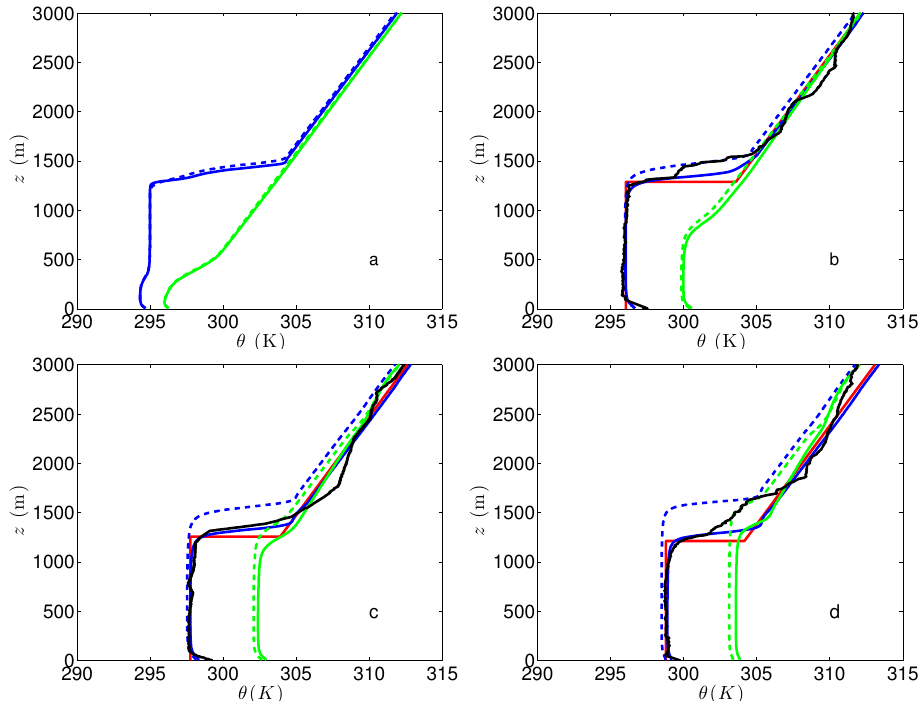
Fig. 3. Vertical profile of the 30-minutes averaged potential temperature at (a) 08:30, (b) 11:00, (c) 14:00 and (d) 17:00 UTC on 1 July 2011 observed by the radio soundings (solid black) and obtained by MLM (solid red) and DALES runs (RLs, solid blue; RLns, dash blue; nRLs, solid green; and nRLns, dash green line).